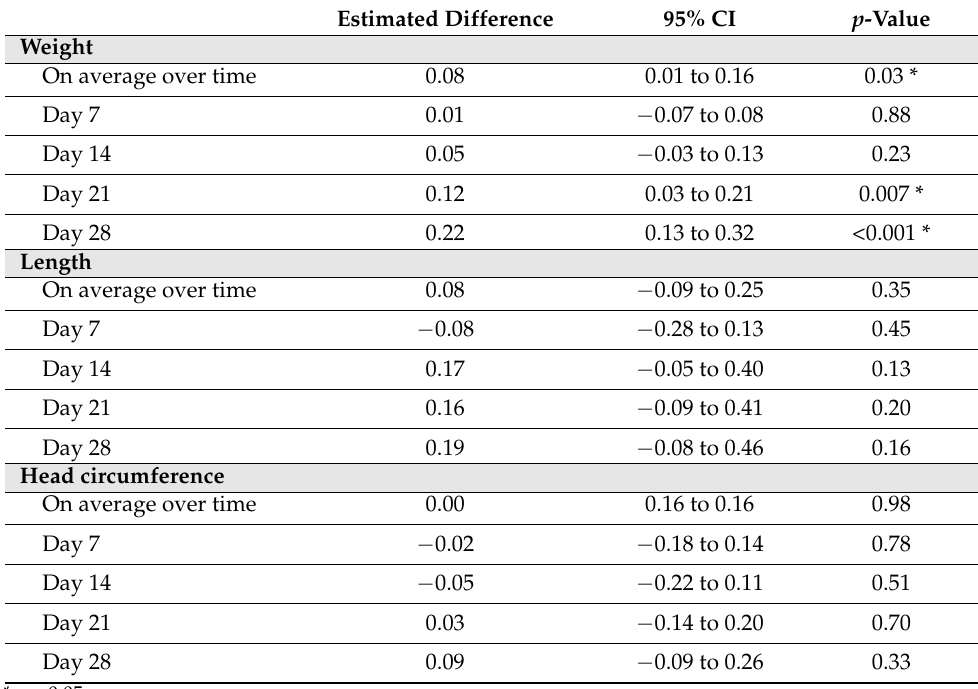
Table 5 indicates the weight, length, and head circumference Z-score change over time and at the different time points. The Z-score change in weight was statistically significant in probiotic group from day 21 onwards, as well as over time. Table 5. Change in the anthropometric measurement Z-scores of the neonates over the trial period. Estimated Difference 95% CI p -Value